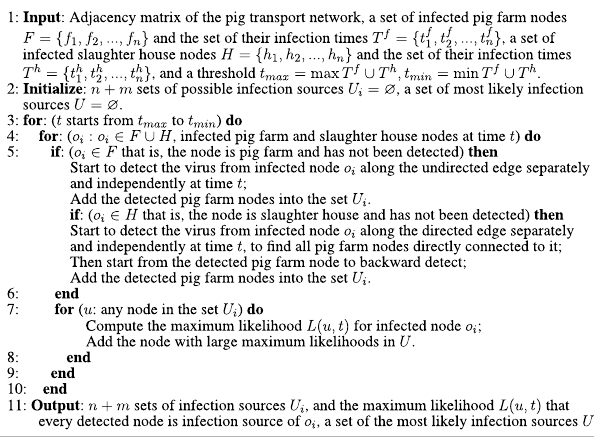
Table 3 | Spatiotemporal backward detection algorithm in a semi-directed weighted